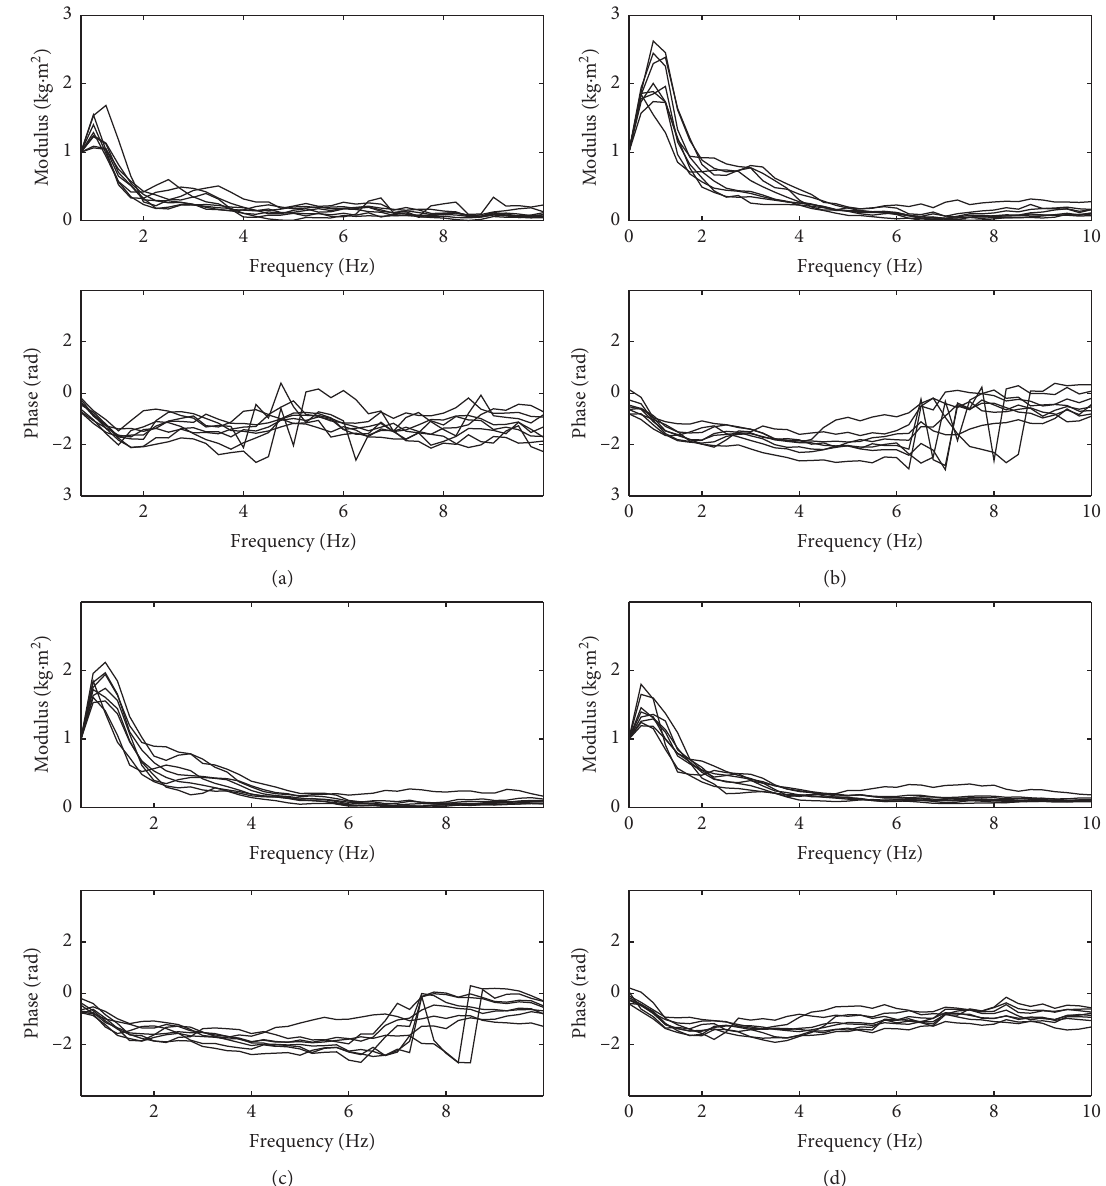
Figure 6: Intersubject variability: normalized apparent inertia of eight subjects at 4 magnitudes of excitation: (a) 0.5 rad/s 2 r.m.s.; (b) 1.0 rad/s 2 r.m.s.; (c) 1.0 rad/s 2 r.m.s.; (d) 1.0 rad/s 2